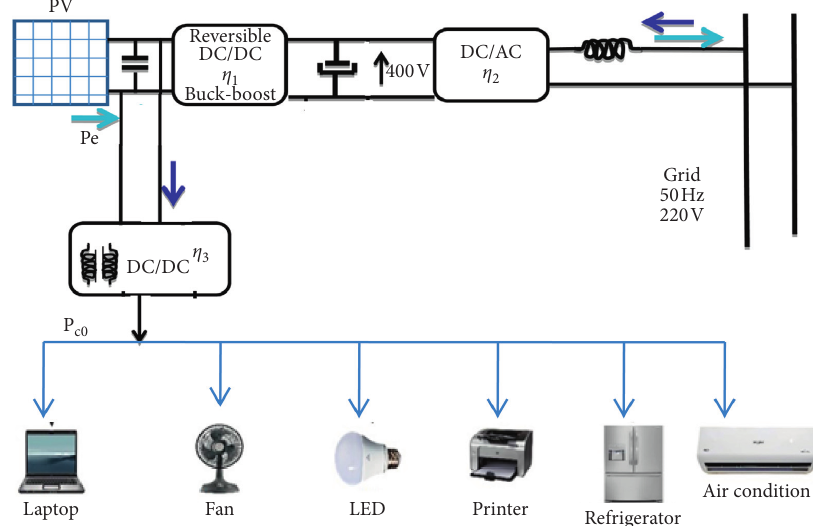
Figure 5: Proposed LVDC architecture (syst3).